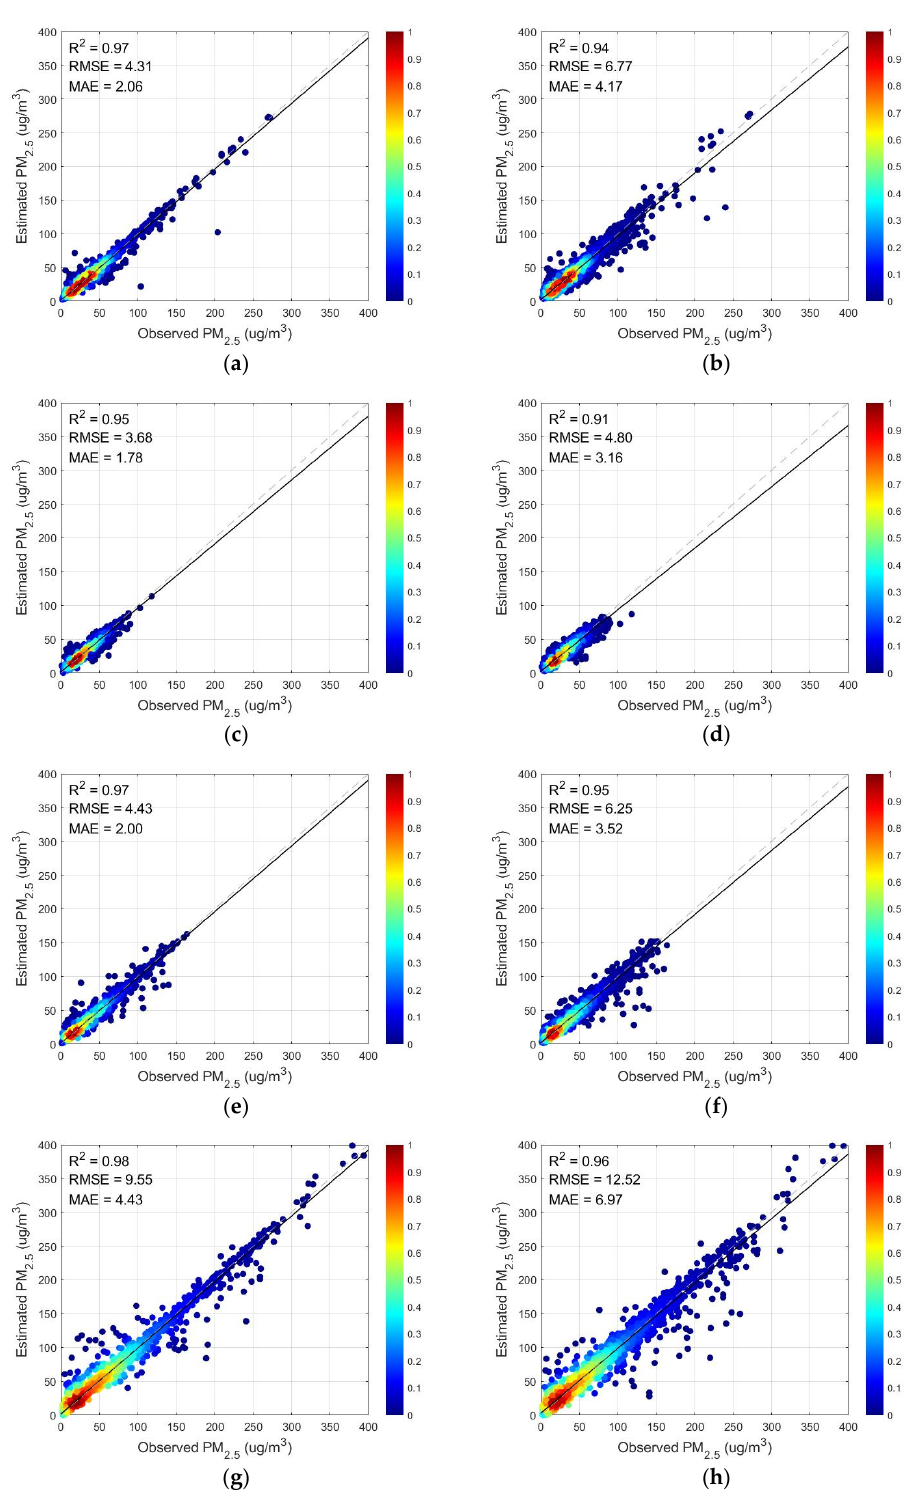
Figure 8. Density scatter plots of PM 2.5 concentrations by seasonal cross-validation results in 2020. TOAR-based on the left and AOD-based on the right, ( a , b ) spring, ( c , d ) summer, ( e , f ) autumn, and ( g , h ) winter; the dashed line is the 1:1 line, and the solid line is the fitted